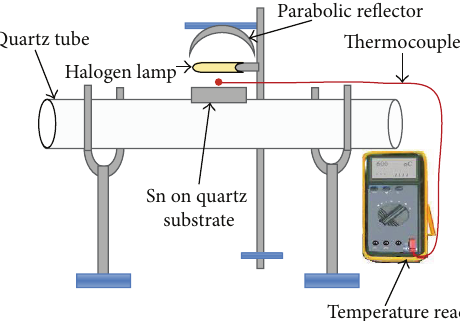
Figure 1: Schematic diagram of the fabricated MIS device.